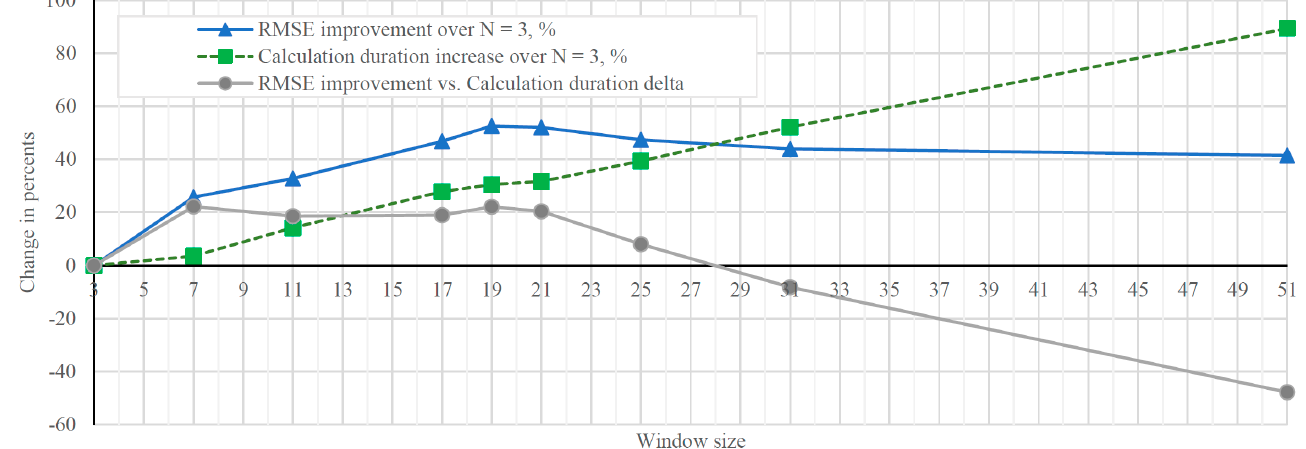
Figure 6. Relative performance and calculation time dependence on sample window size.